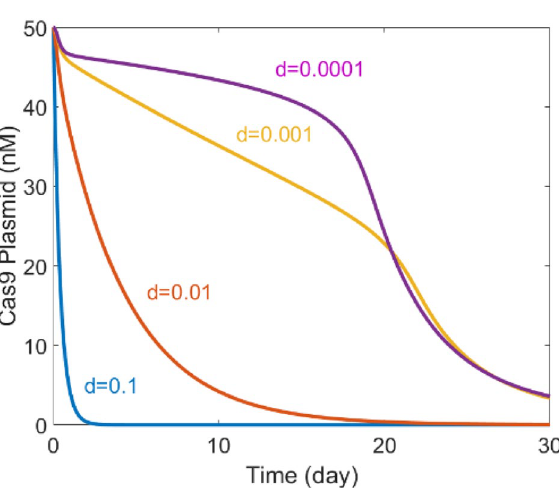
Figure 5. Time-delayed Cas9 elimination in different cell lines (d = 0.1, 0.01, 0.001, 0.0001). d stands for dilution